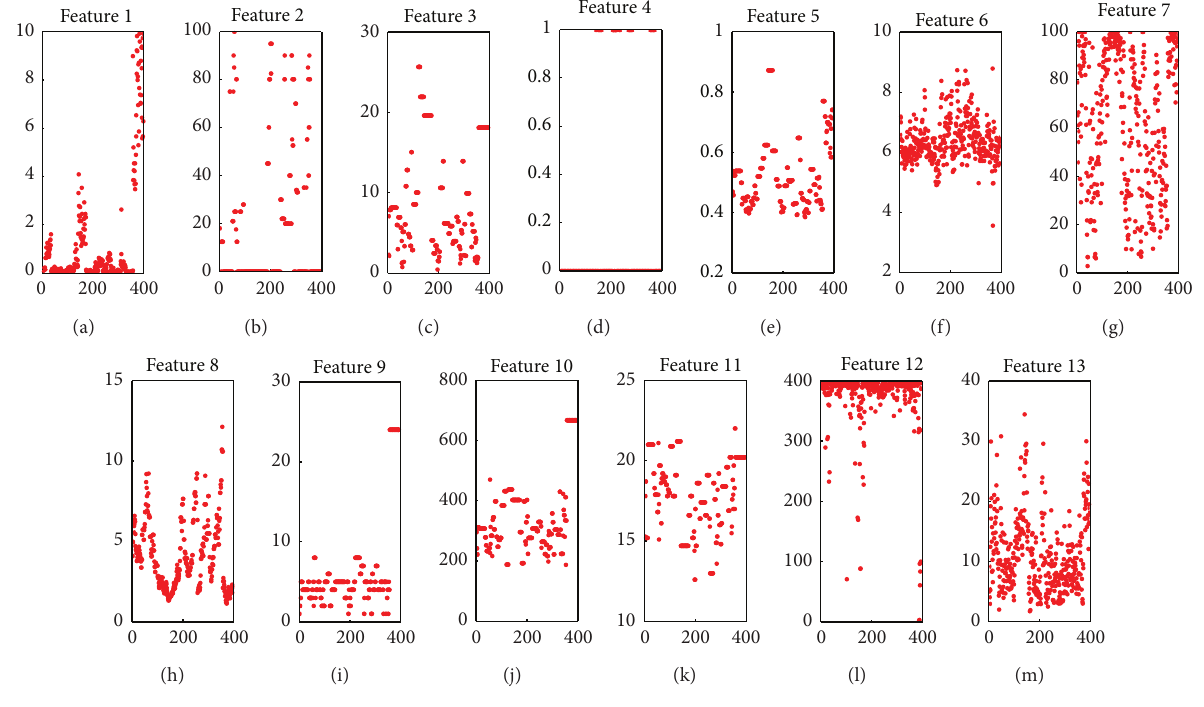
Figure 1: Features of the training